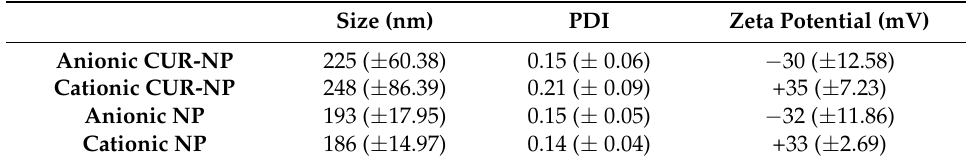
Table 1. Mean values of size, poly-dispersion index (PDI), and zeta potential ( ± standard deviation) of NPs formulations with and without CUR determined in dynamic light scattering (DLS) in a period interval of 0–29 days after the synthesis ( n = 12).